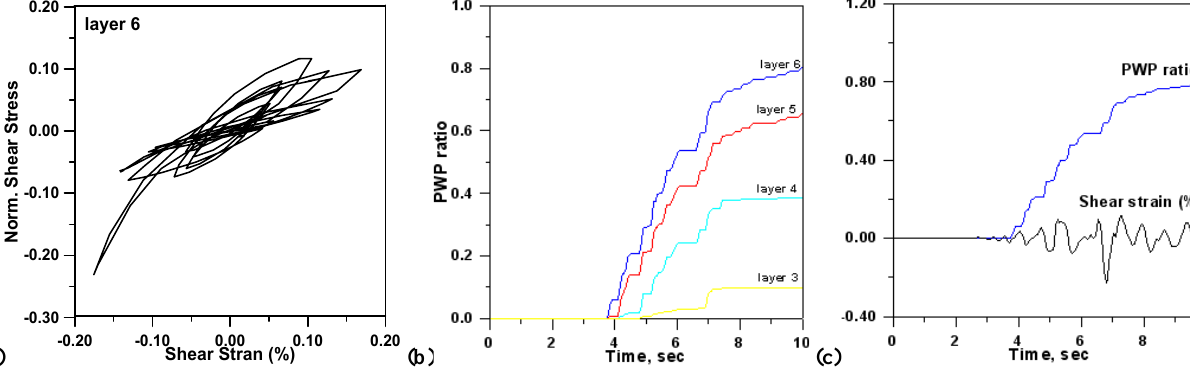
Fig. 12. Non-linear soil response analysis results for site AA: (a) Stress-strain history for the layer with high probability to liquefy; (b) PWP time histories at different depths in the soil column; (c) PWP and shear strain time histories for the layer with high probability to